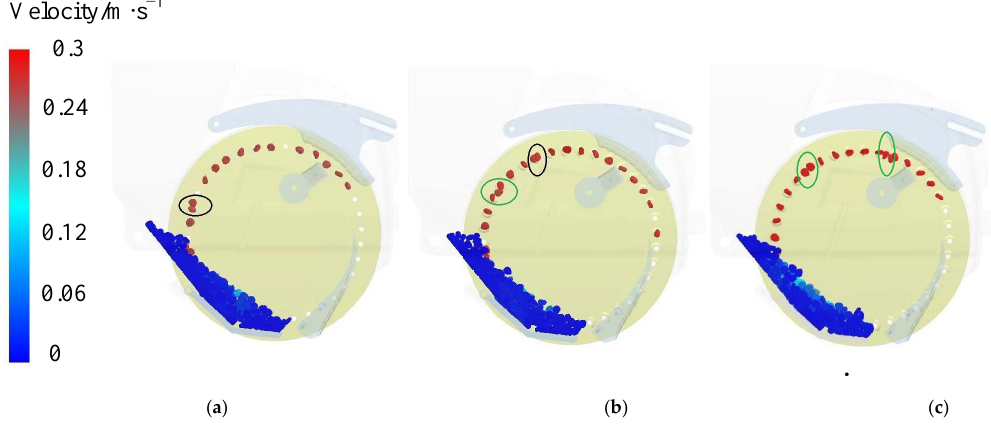
Figure 16 . Dynamic simulation process of the seed metering device sucking seeds under different groove depths. ( a ) 0.5 mm, ( b ) 1.5 mm, ( c ) 2.5 mm. Note: The black circle represents the sucked multiple seeds, and the green circle represents stuck seeds.